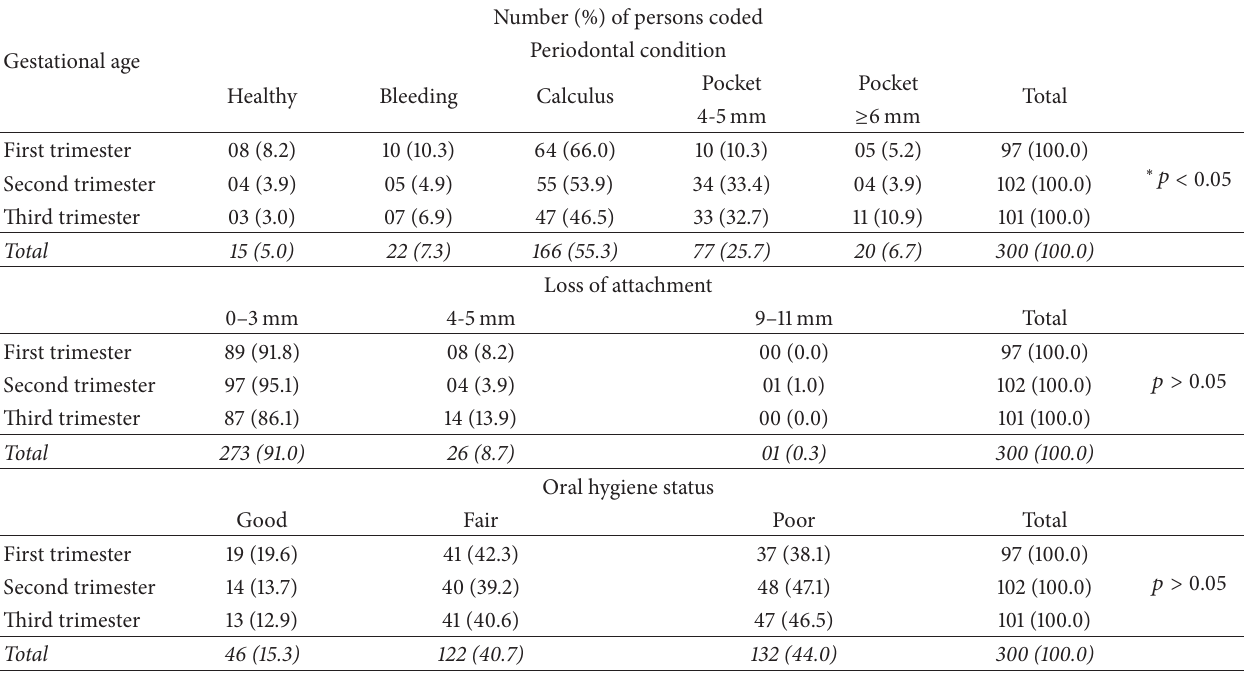
Table 5: Association between gestational age, periodontal condition, loss of attachment, and oral hygiene status in pregnant women. Number (%) of persons coded Periodontal condition Gestational age Healthy Bleeding